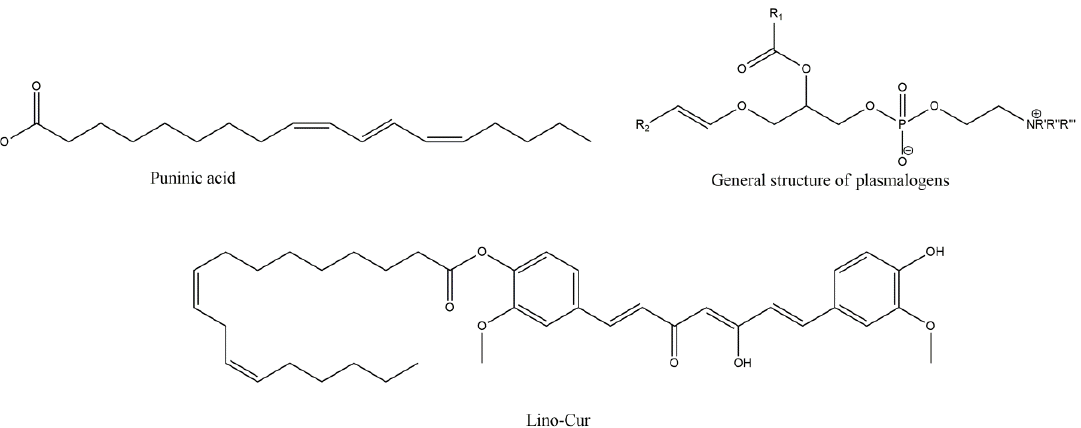
Figure 7. Punicic acid, general structure of plasmalogens (R’ = R’’ = R’’’ = -CH 3 or -H, R 1 = ω - 3 or ω -6 lipid moiety, R 2 = saturated or mono-unsaturated lipid moiety) and linoleic acid with curcumin synthetic derivative Lino-Cur.